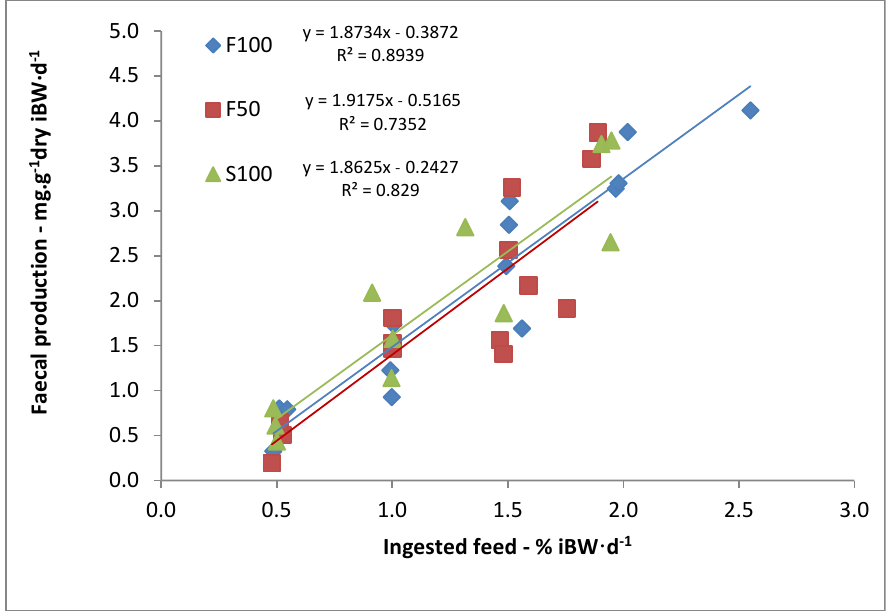
Figure 1. Relationships between fecal production of juvenile crabs and ingested feed for the three experimental diets. Amount of feed intake is percentage of initial fresh body weight (iBW) per day.